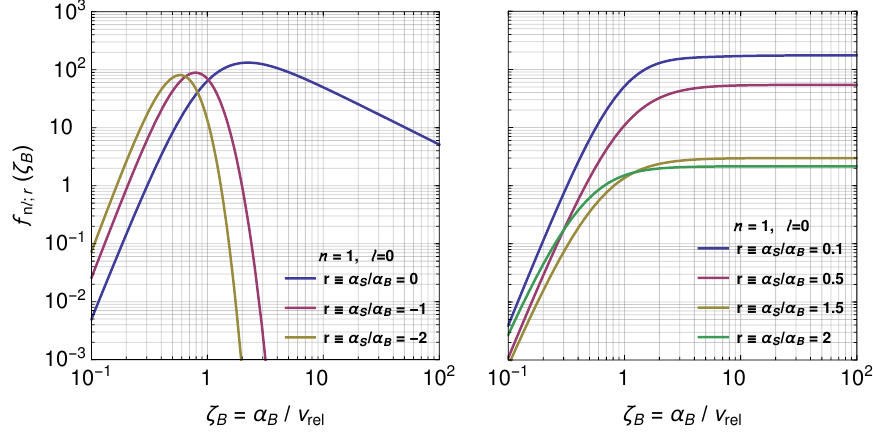
Figure 7 . f n‘ ; r (cid:17) (cid:11) (cid:0) 1 The coupling (cid:11) all velocities. This is possible because f n‘ ; r is bounded from above.